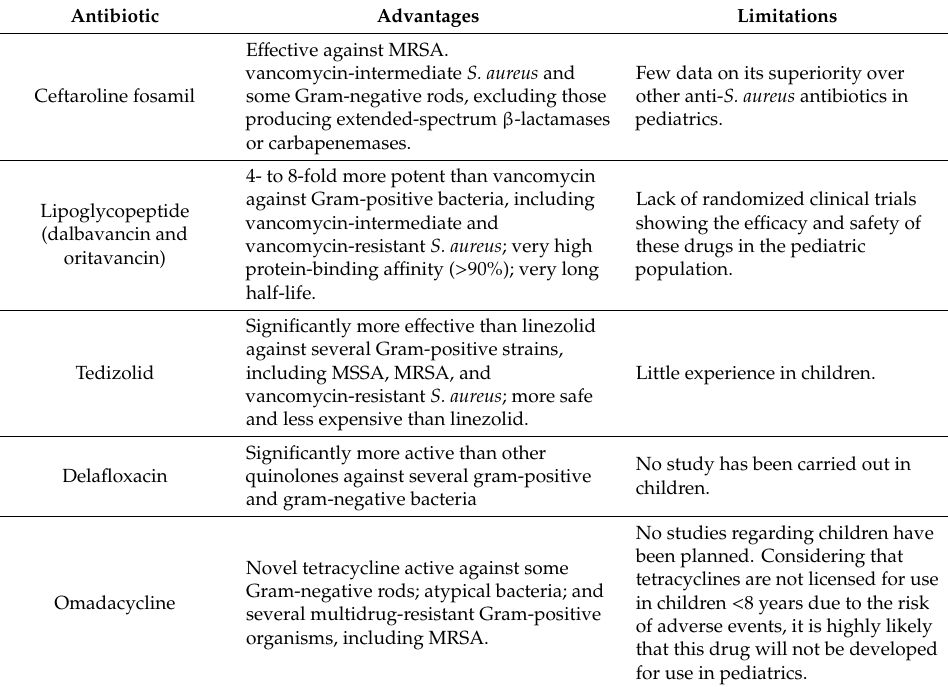
Table 2. New oral and parenteral antibiotics for the treatment of acute bacterial skin and soft tissue infections in